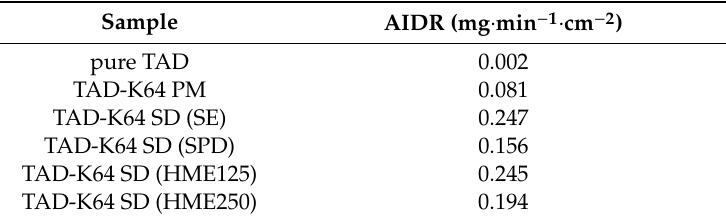
Table 2. Apparent intrinsic dissolution rate of TAD (K64 polymer